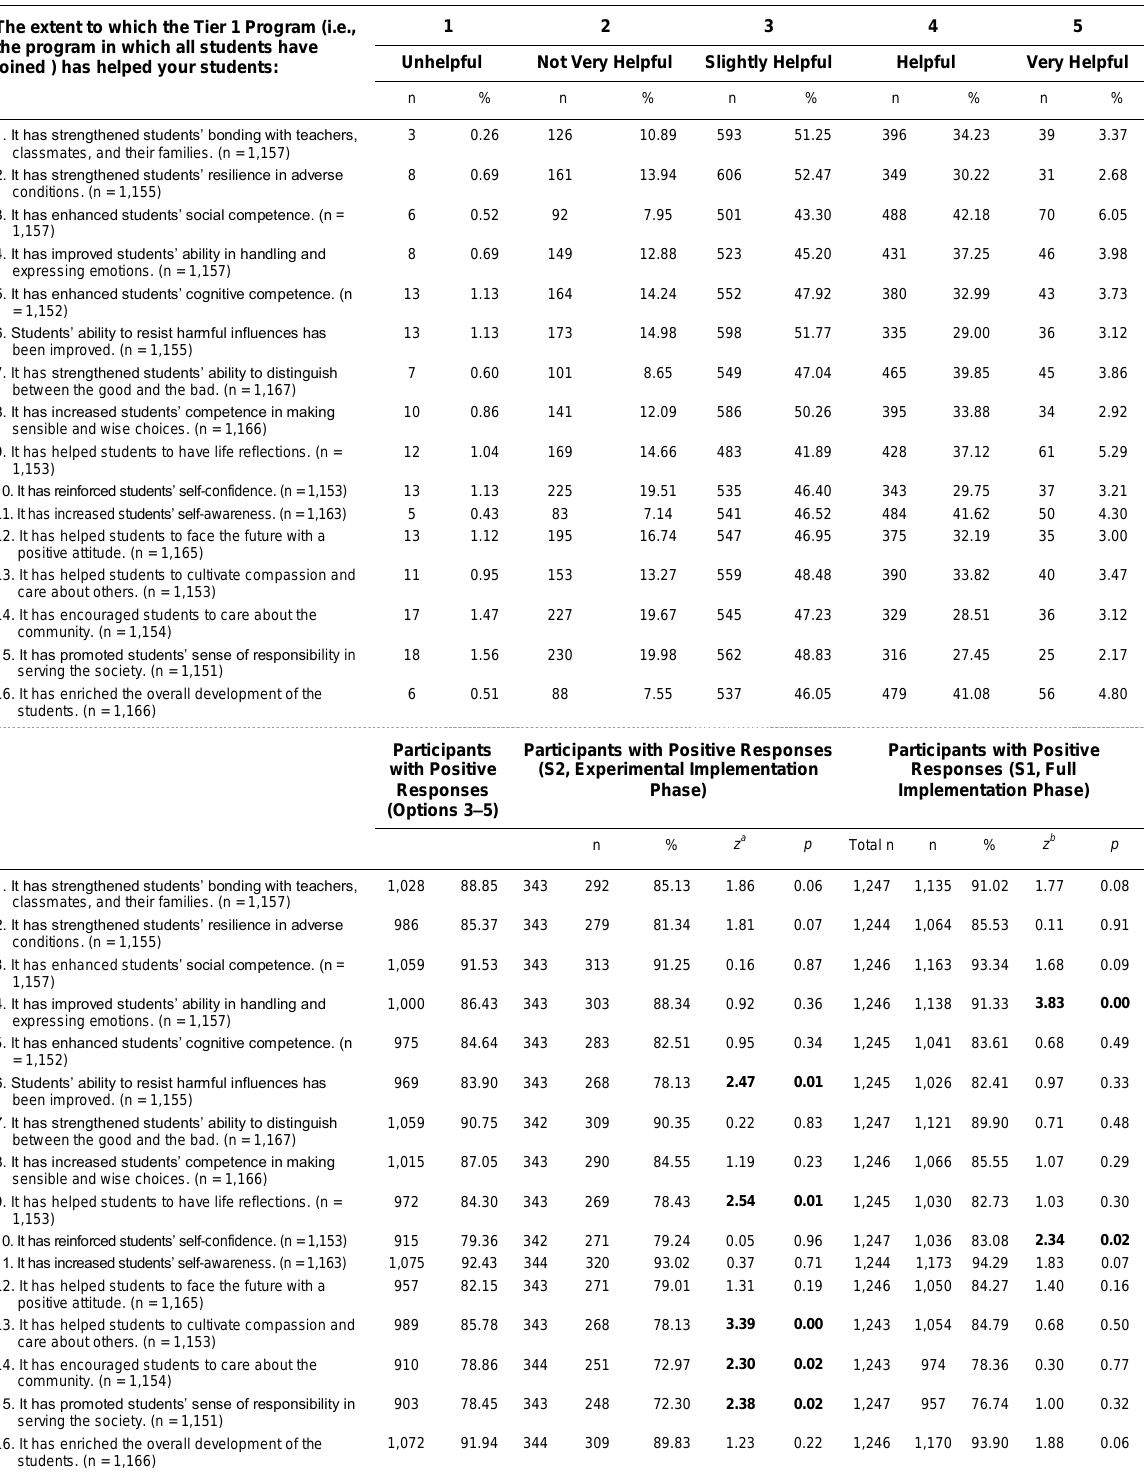
Perceived Effectiveness of the Program by the Program